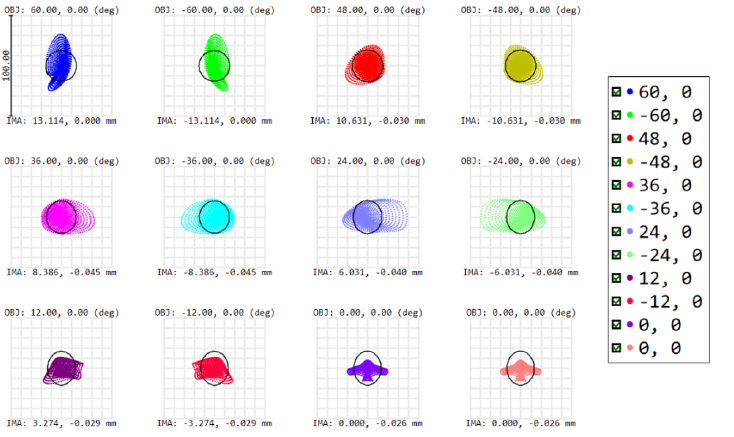
Figure 7. Spot diagram as the first figure of merit for our telescope optical performance. All RMS spot sizes are approximately the size of the Airy disk (indicated by the black circle) at a wavelength of 1700 nm, resulting in a nearly diffraction-limited design. Symmetry is properly achieved with respect to the 0°. OBJ (in degrees) defines the object field and IMA (in mm) defines the image height of the centroid on the detector. The different colors correspond to the different fields shown in Figure 4.